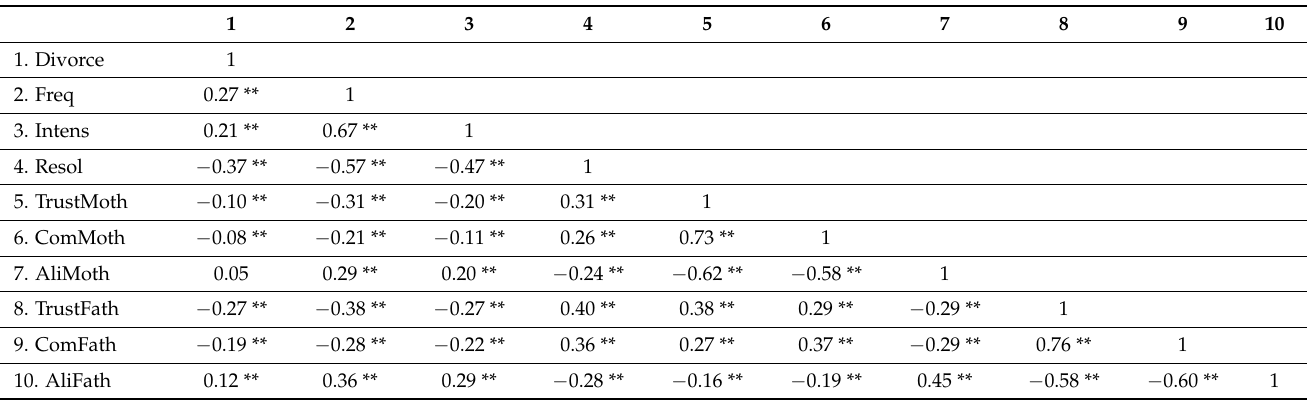
Table 2. Correlations among the study variables.